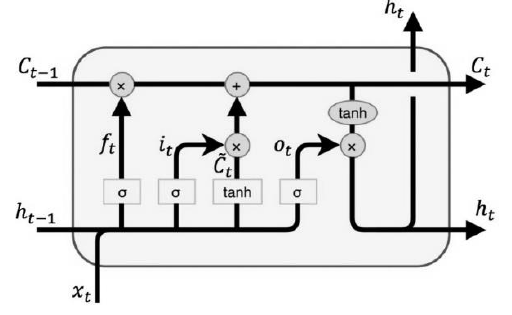
Fig. 6. LSTM cell of ANN .